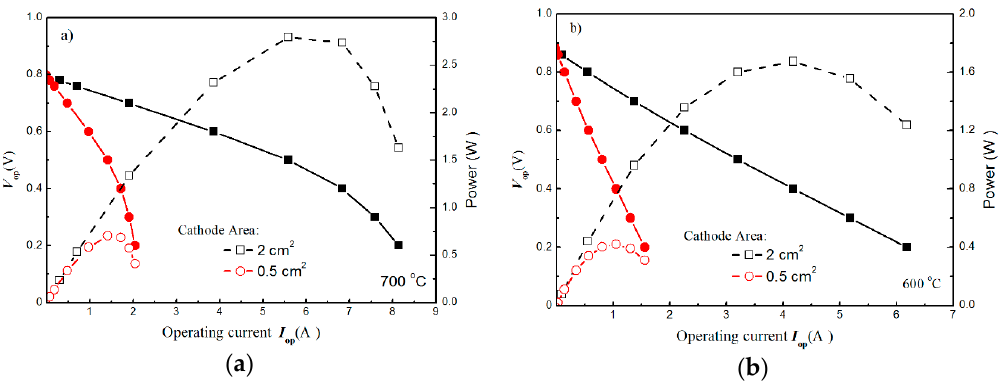
Figure 4. Effects of different cathode areas on cell, ( a ) I op - V op performances at 700 °C; ( b ) I op - V op performances at 600 °C.